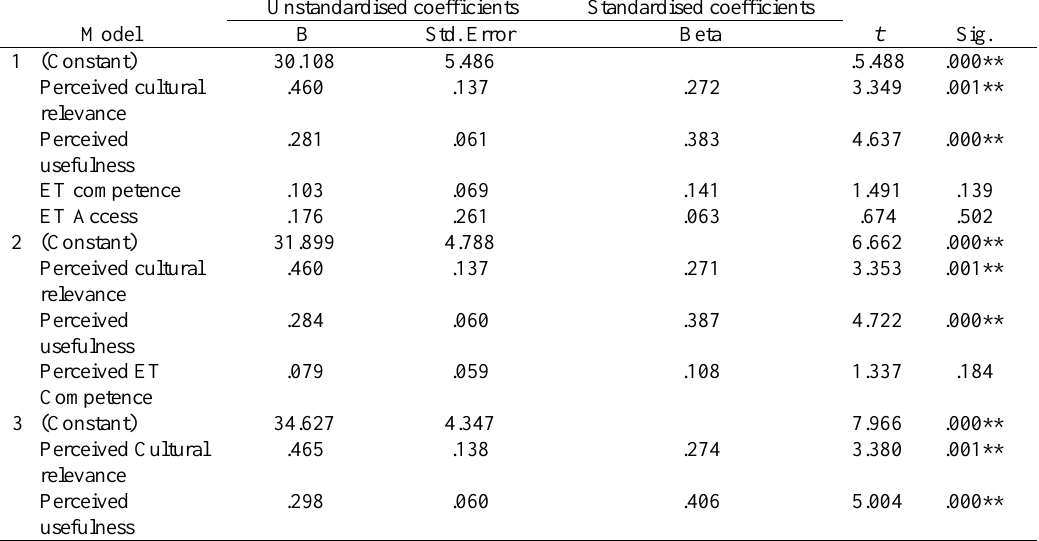
Table 4 Multiple regression analysis for teacher attitudes and perceived usefulness, perceived cultural relevance, ET access and ET